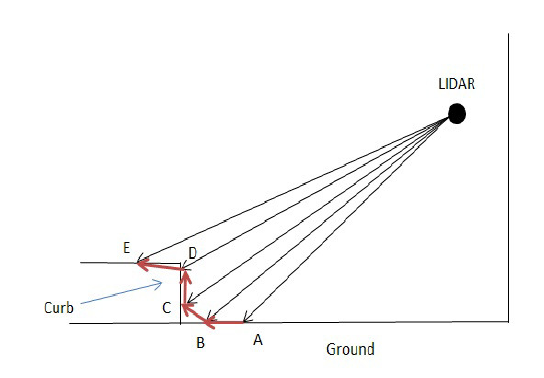
Figure 4. Points selected on the curb. A , B , C , D are 3D points obtained by LiDAR. B and C are selected as points on the curb since the vectors (cid:126) BC and (cid:126) CD are more